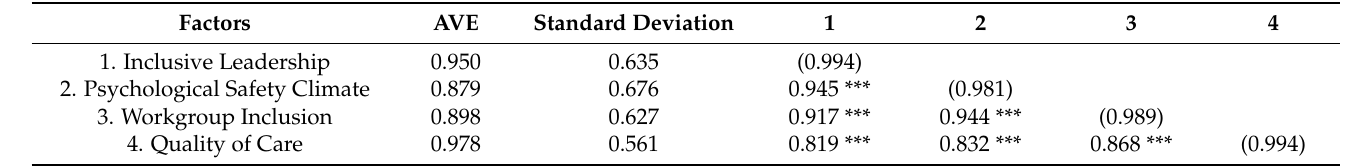
Table 3. Convergent validity, interfactor correlations, and construct reliability.